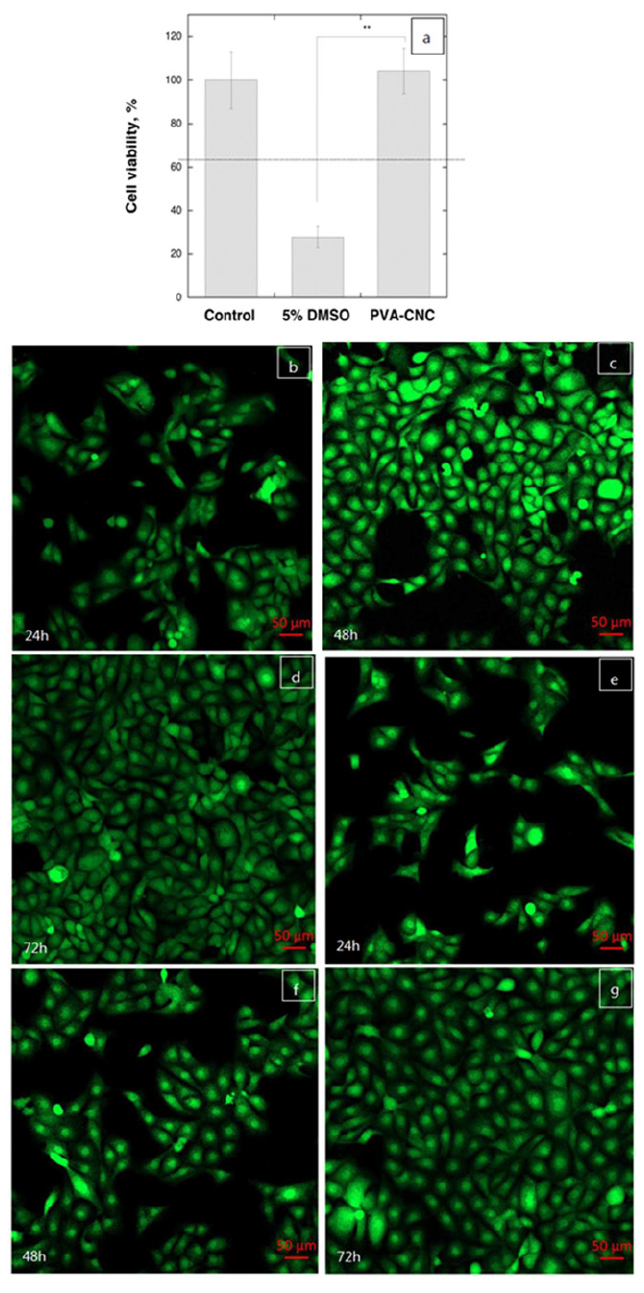
Figure 11. Biocompatibility study: ( a ) cell viability of HCE-2 cells cultured in extract medium of CNC-PVA/DMSO; the data are expressed as percentage of the negative control (tissue culture plate extract medium) and represent the mean ± SEM (** p < 0.01). ( a – c ) Confocal microscopy images of GFP-labeled HCE-2 cells cultured on CNC-PVA hydrogels: ( b ) growth after 24 h, ( c ) growth after 48 h, ( d ) growth after 72 h. ( e – g ) Confocal microscopy images of GFP-labeled HCE-2 cells cultured on TCP: ( e ) growth after 24 h, ( f ) growth after 48 h, ( g ) growth after 72 h. Reprinted with permission from the authors of [138]. Copyright 2016 American Chemical Society.